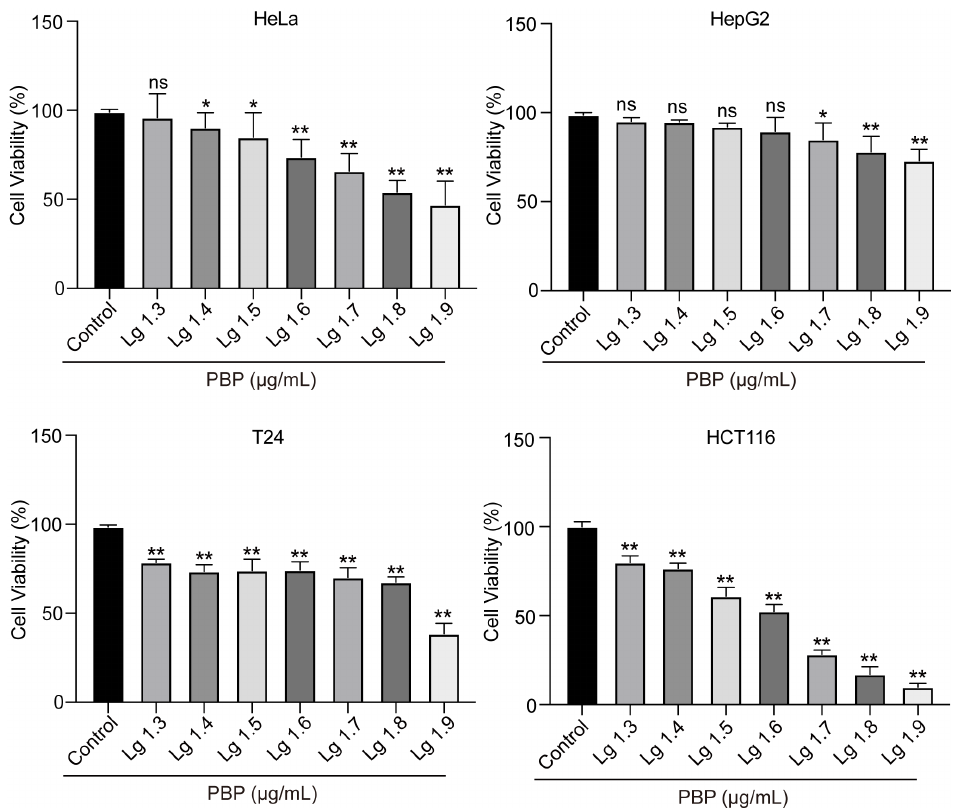
Figure A1. Cytotoxicity of PBP to Hela, HepG2, T24 and HCT116 human tumor cells using the CCK-8 assay, after being exposed to varying amounts of PBP for 48 h. Data are presented as the mean ± SD ( n = 3) by One-way ANOVA analyses. ** p < 0.01 versus control (0 μg/mL PBP).